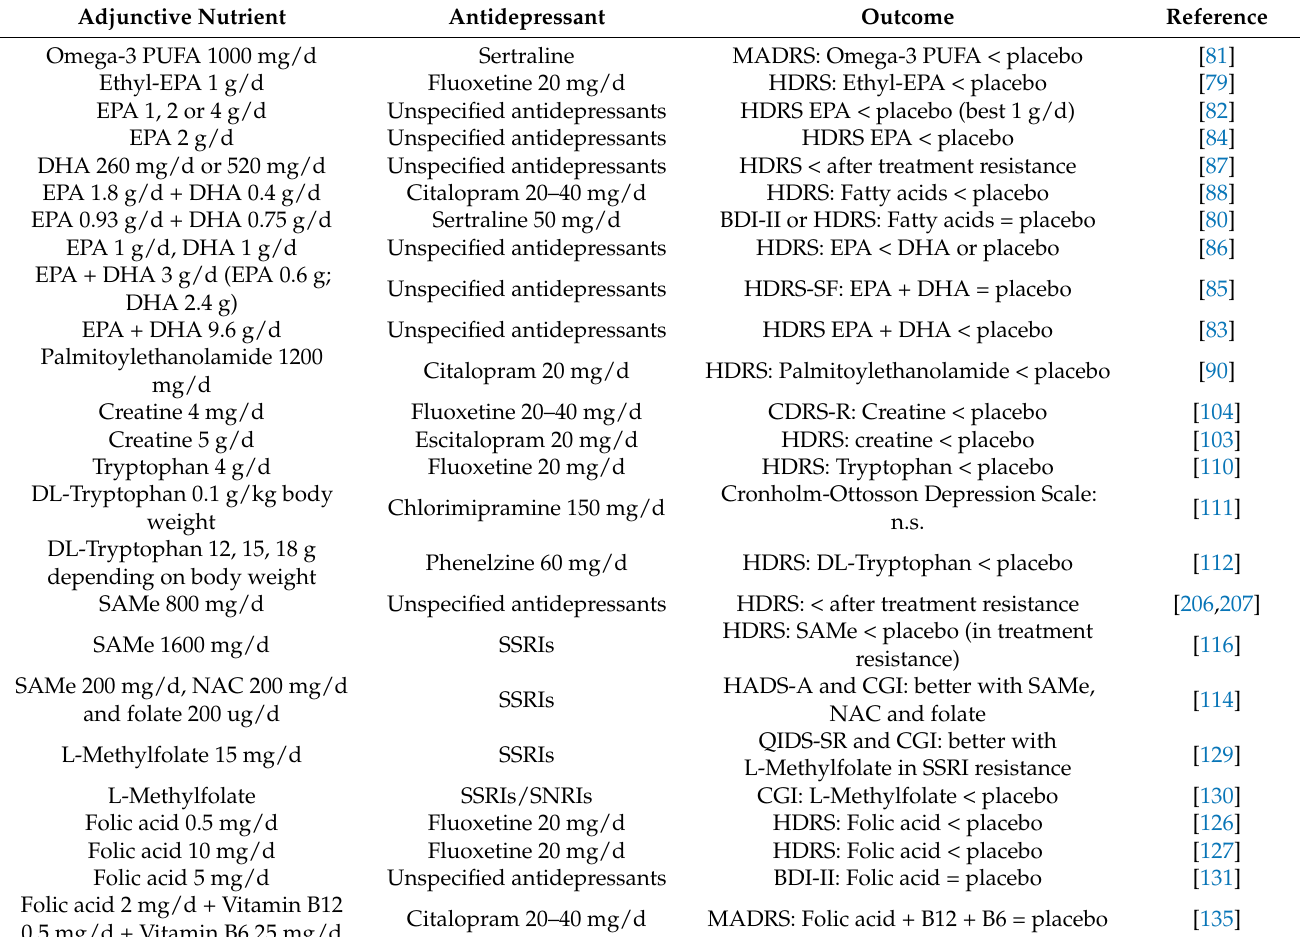
Table 1. Studies on the impact of dietary factors on antidepressant response.